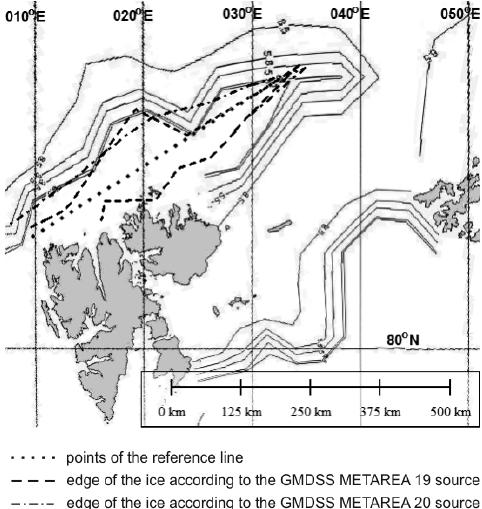
Fig. 2. Map of computational ice concentration of the AARI